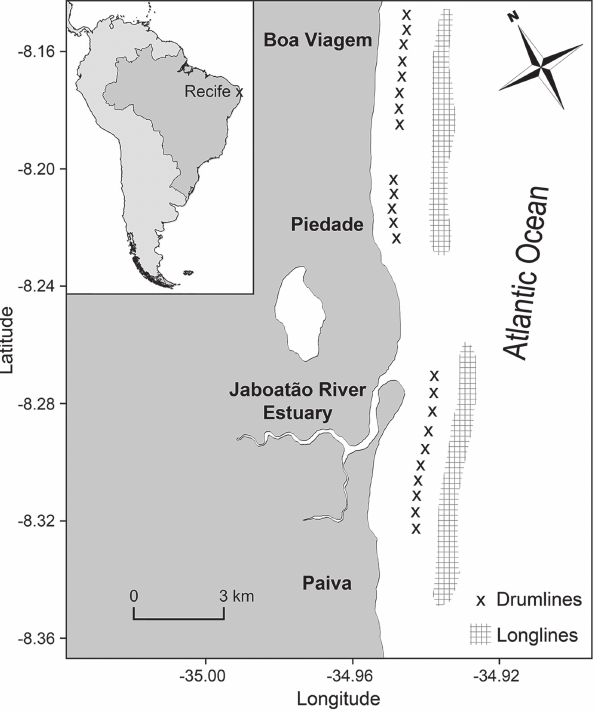
Fig. 1. Map of the study area with the locations of Recife in South America, and fishing sites, i.e . Boa Viagem, Piedade and Paiva beaches. The deployment locations of the respective fishing gears, i.e . each drumline (x) and the two longlines, are also